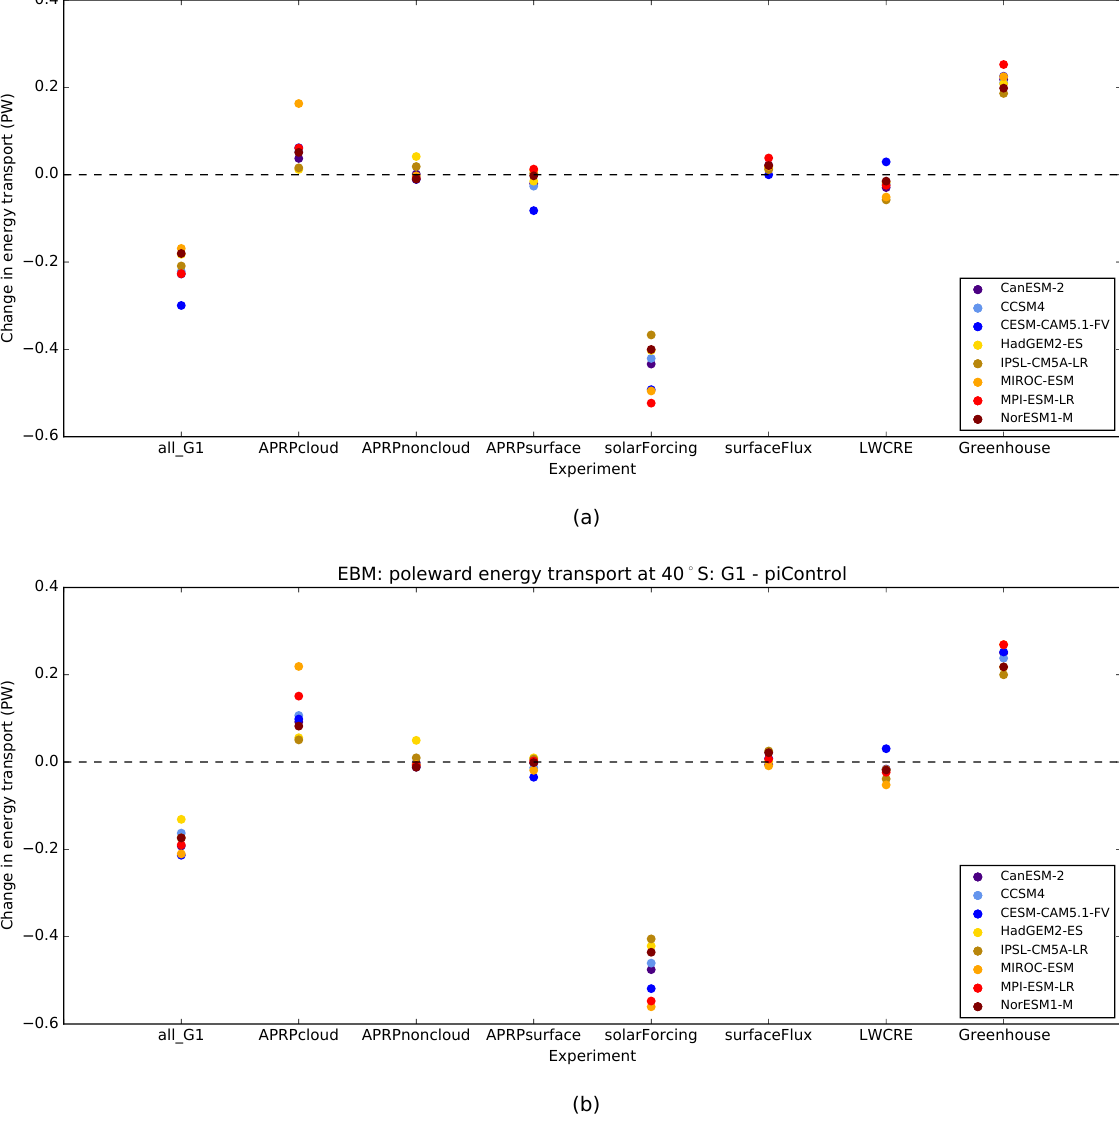
Figure 7. As in Fig. 6 but for changes in poleward atmospheric energy transport across 40 ◦ N (a) and 40 ◦ S (b) , for G1 –